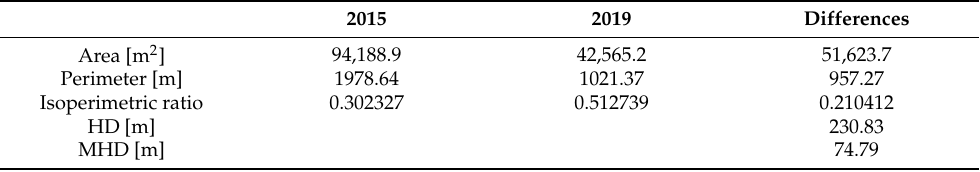
Table 5. Characteristics of the final segmentation curves from Figure 12 final segmented areas showing their difference in area, perimeter, isoperimetric ratio and classical (HD) and mean (MHD) Hausdorff distances of two segmentation curves.